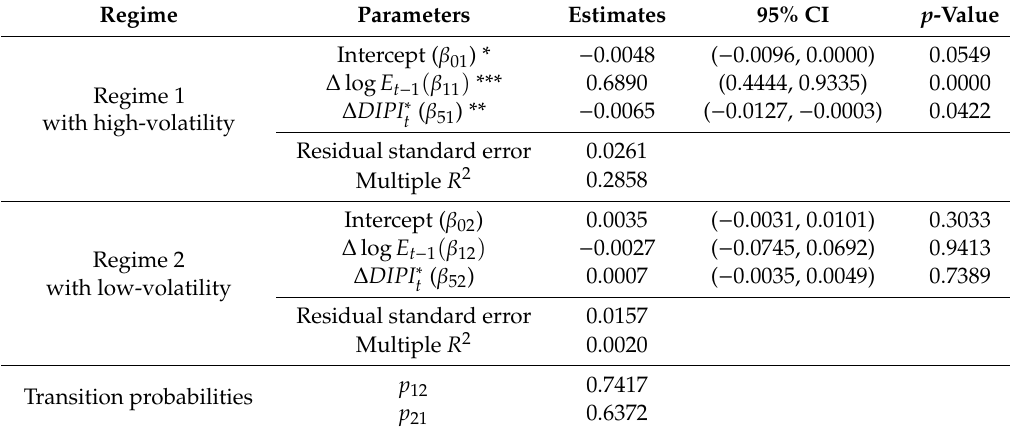
Table 6. Parameter Estimates of the Selected MRSM in